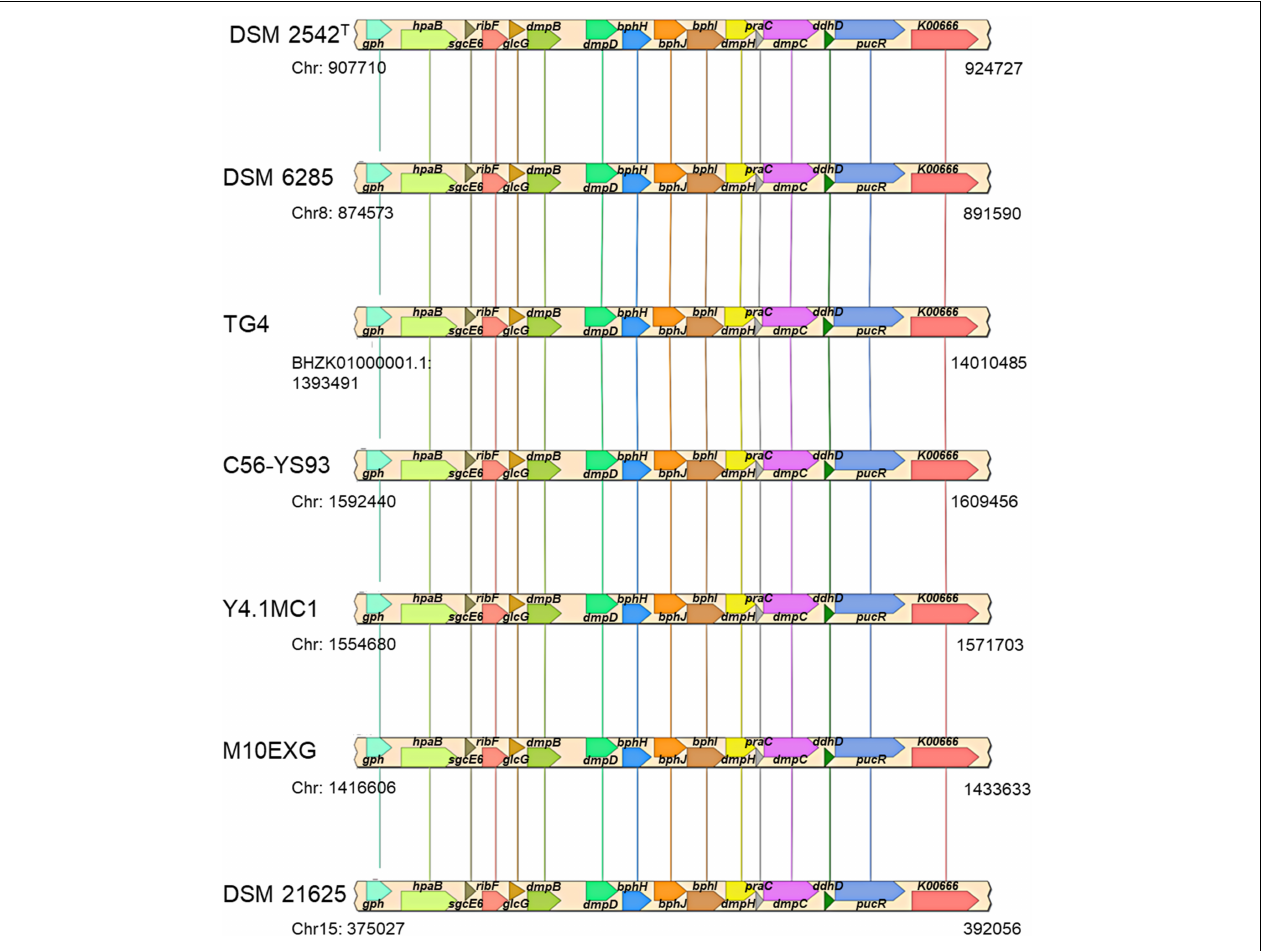
FIGURE 8 | Organization of a chromosomal phenol degradation locus (PtPL) shared by all P. thermoglucosidasius strains. K00666, pucR, ddhD, dmpC, praC, dmpH, bphI, bphJ, bphH, dmpD, dmpB, glcG, ribF, sgcE6, hpaB , and gph code for fatty-acyl-CoA synthase, purine catabolism regulatory protein, CDP-4-dehydro-6-deoxyglucose reductase, 3, aminomuconate-semialdehyde, 4-oxalocrotonate tautomerase, 2-oxo-3-hexenedioate decarboxylase, 4-hydroxy-2-oxovalerate/4-hydroxy-2-oxohexanoate aldolase, acetaldehyde/propanal dehydrogenase, 2-oxopent-4-enoate/ cis- 2-oxohex-4-enoate hydratase, 2-hydroxymuconate-semialdehyde hydrolase, catechol 2,3-dioxygenase, glc operon protein, riboflavin kinase/FMN adenylyltransferase, flavin reductase, 4-hydroxyphenylacetate 3-monooxygenase, and phosphoglycolate